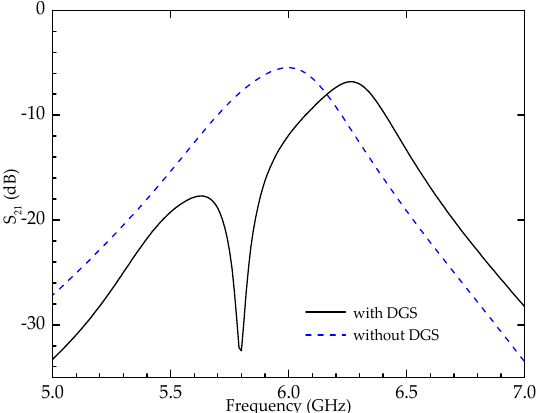
Figure 5. Isolation of the MIMO antenna without DGS and with DGS at the back plane side, focus on 5.8 GHz.